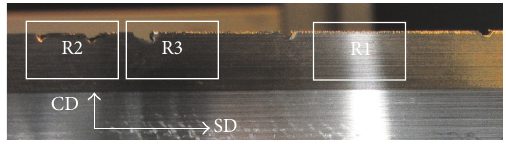
Figure 7: Wood Chipping